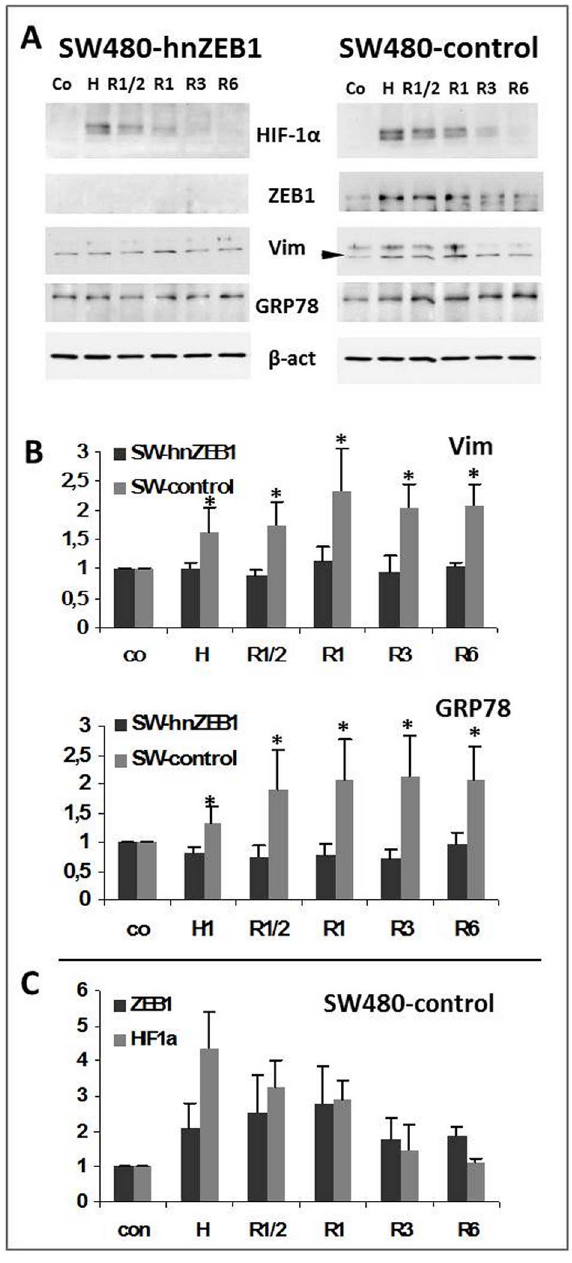
Figure 4. Development of EMT and ER-stress in SW480-shZEB1 and SW480-control cells under conditions of hypoxia and reoxygenation. A Confluent growing SW480-shZEB1 and SW480- control cells were exposed to normoxia and hypoxia-like conditions (6 h; serum free; 100 m M CoCl 2 ) followed by reoxygenation (normal medium). Proteins were extracted at conditions of normoxia (control, Co), hypoxia (H) and reoxygenation (R) after K h (R K ), 1 h (R1), 3 h (R3) and 6 h (R6). Amounts of HIF1 a , ZEB1, vimentin (Vim), GRP78 and b -